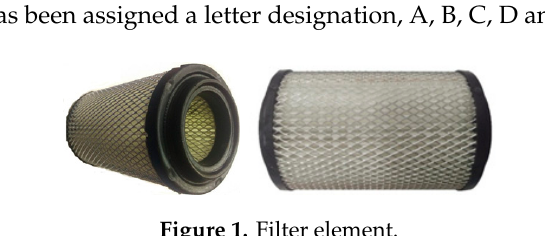
Figure 1. Filter element.